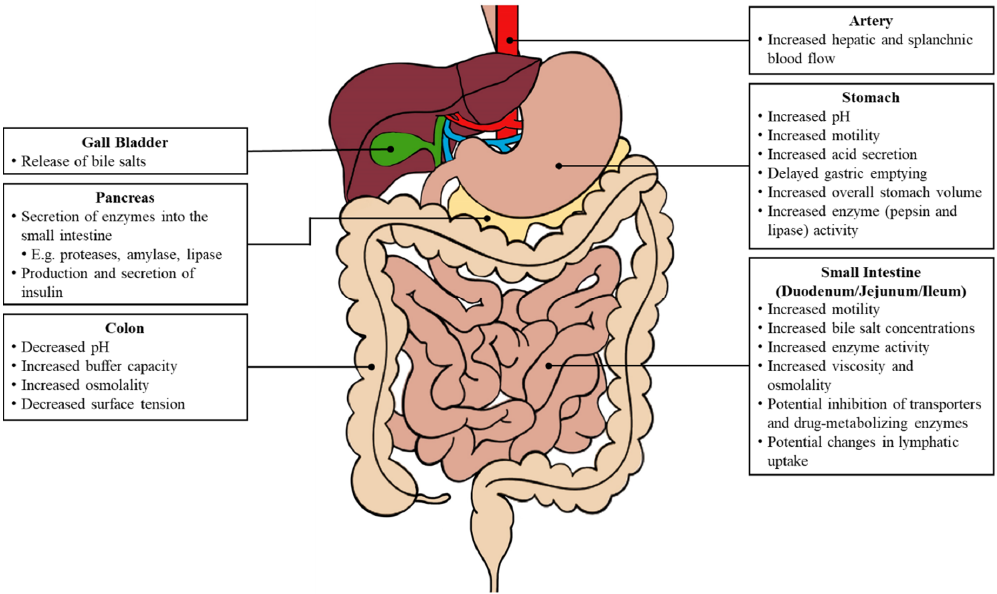
Figure 2. Major physiological changes in the gastrointestinal tract following food consumption. Adapted from reference